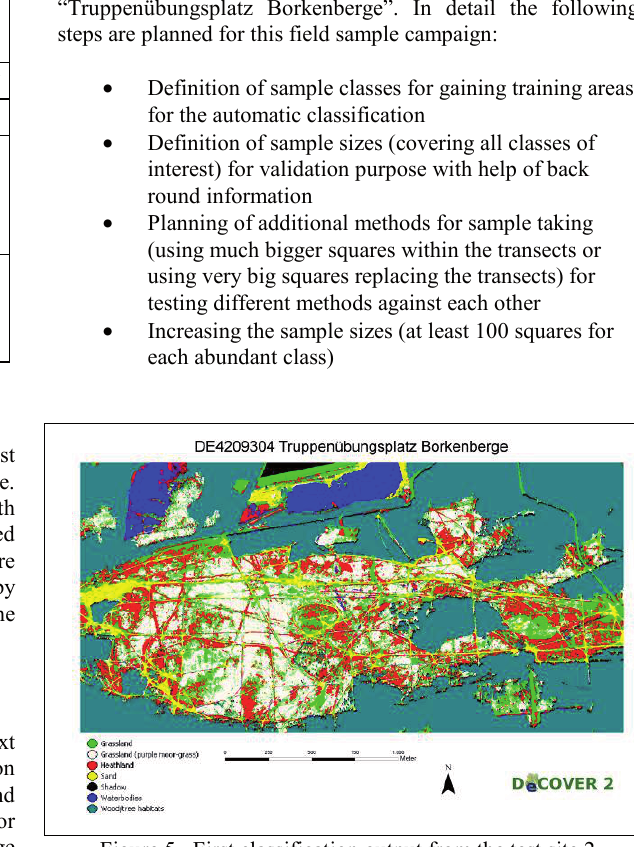
Figure 5. First classification output from the test site